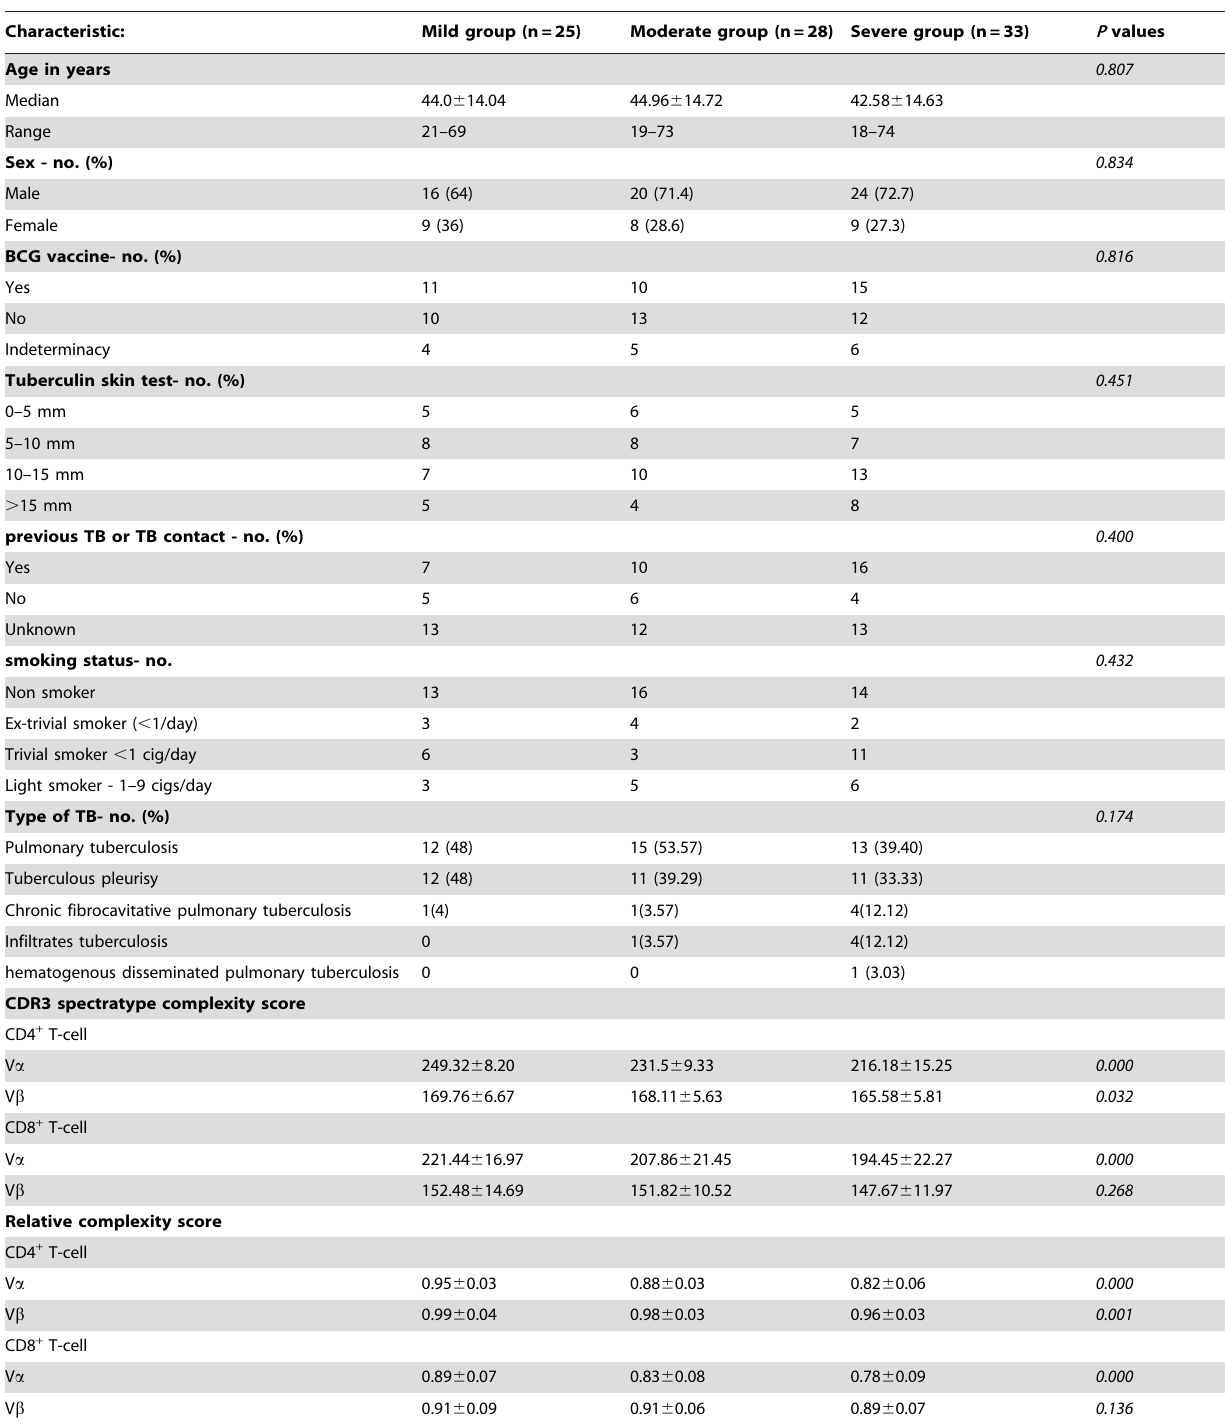
Table 1. Baseline characteristic and CDR3 scores of TB